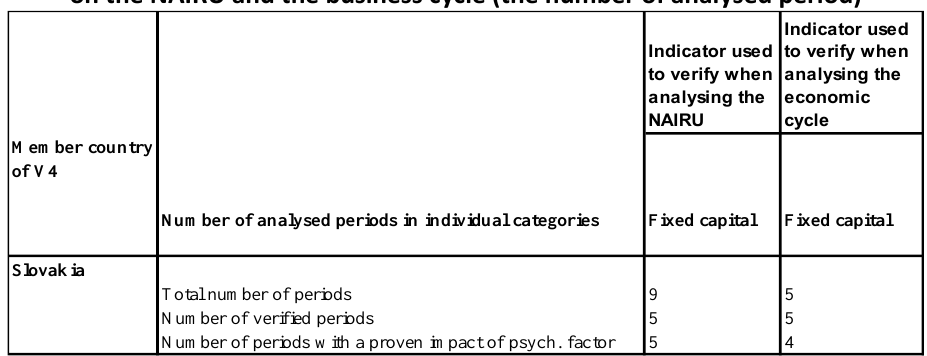
Table 3. Quantification of the intensity actually established the influence of psychological factors on the NAIRU and the business cycle (the number of analysed period)